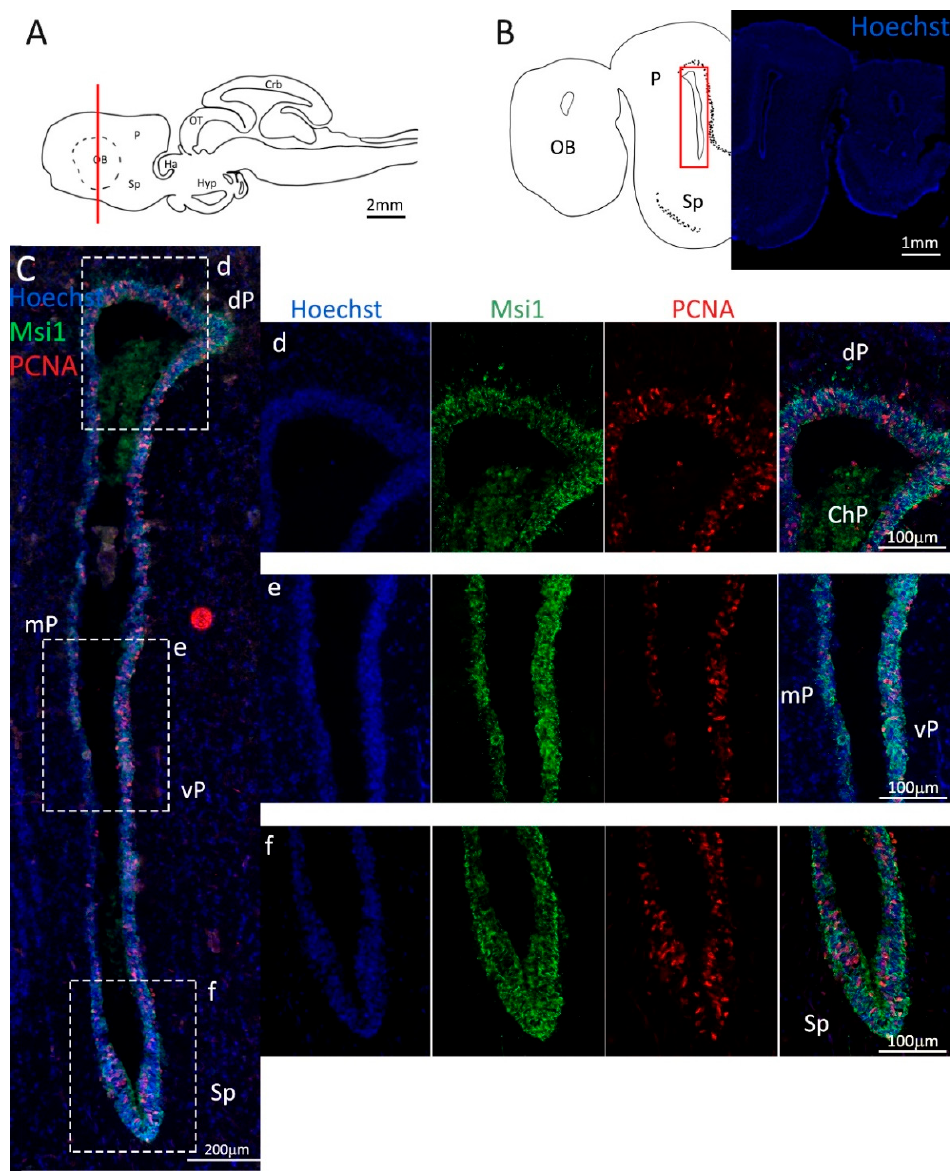
Figure 2. Localization of PCNA (red) and Msi1 (green) positive cells in the anterior telencephalon of S. canicula . ( A ) Sagittal representation of S. canicula brain. The red line indicates the rostro-caudal localization of the section represented in the panel. ( B ) Coronal map of the anterior telencephalon. On the right, a real coronal section is stained with Hoechst 33342 to show nuclei distribution; on the left, a cartoon is drawn to indicate anatomical references. Red rectangle identifies the general area from which images are taken. ( C ) Progenitor cells in the anterior telencephalic neurogenic niche. Progenitor cells (Msi1 + , green) are localized around the ventricular wall. ( d ) Magnification of the neurogenic niche localized in the dP. ( e ) Magnification of the neurogenic niche localized in the mP and vP. It is evident the major thickness of the progenitor cells layer on the side of the vP in respect to the mP, as well as the higher number of PCNA + cells (red). ( f ) Magnification of the neurogenic niche localized in the Sp. Abbreviations: OB: olfactory bulb, P: pallium, Sp: subpallium, dP: dorsal pallium, mP: medial pallium, vP: ventral pallium, ChP: choroid